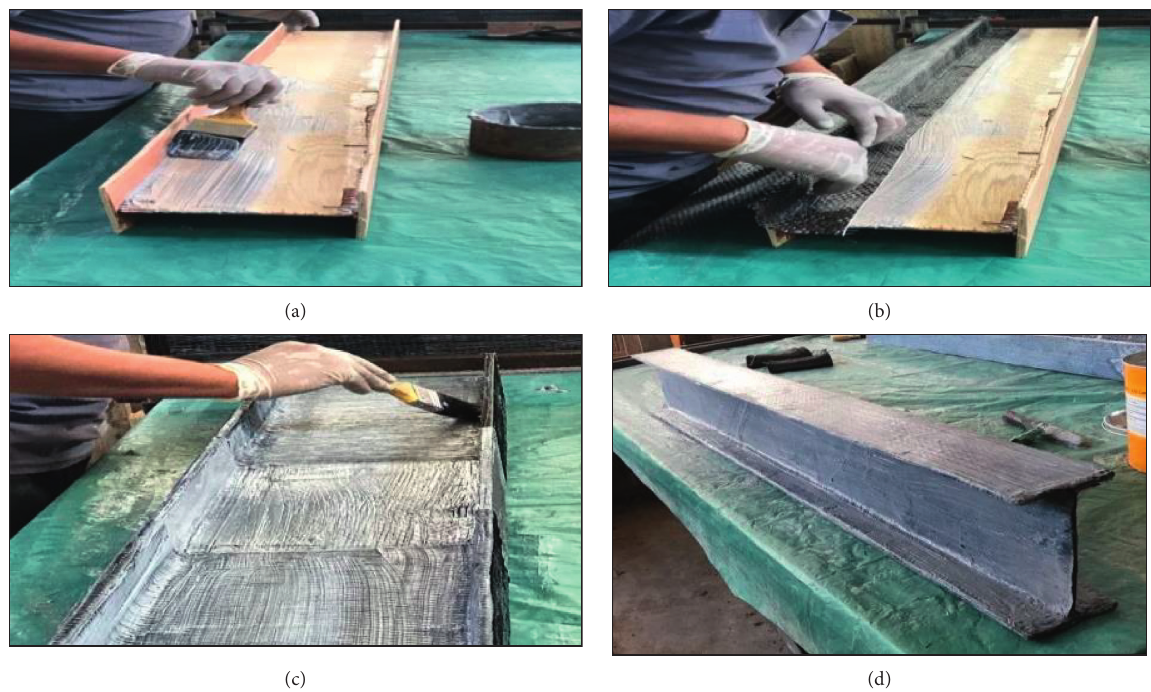
Figure 3: Preparation of specimens. (a) The resin was coated on the wood. (b) Fiber sheet (first ply) was placed on the coating. (c) Putting the plies one over the other with a matrix. (d) Hybrid CFRP laminated